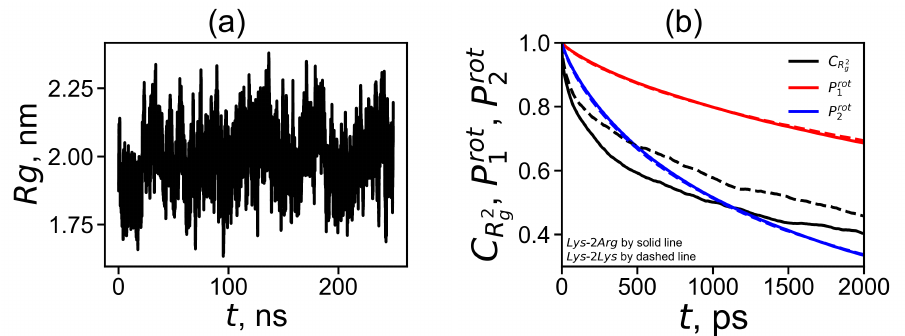
Figure 2. ( a ) The time evolution of the mean-squared gyration radius R g for the Lys-2Arg dendrimer at T = 310 K, ( b ) the autocorrelation functions (ACFs) for Lys-2Arg and Lys-2Lys: the orientational ACFs ( t ) and P rot ( t ) for the core-to-end vector and the ACF for the pulsation of R 2 P rot 2 1 T = 310